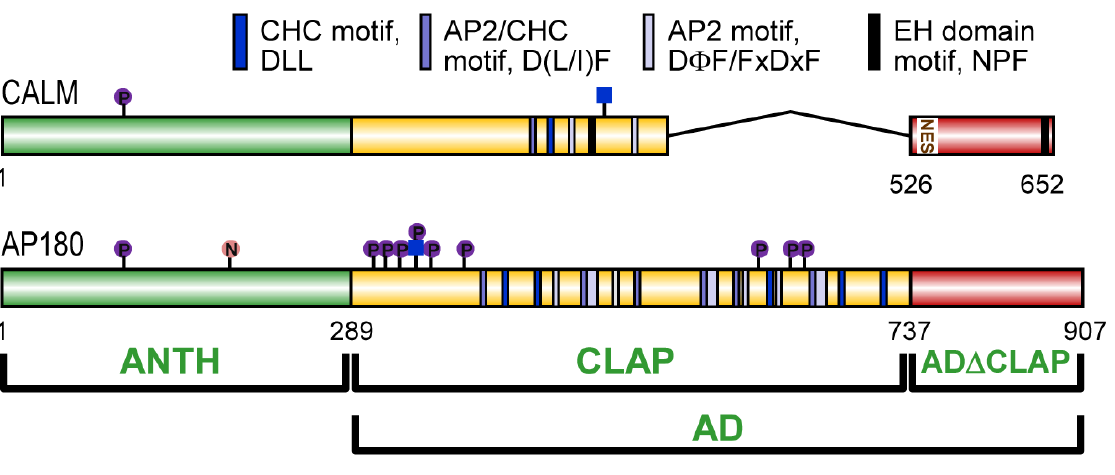
Figure 2. Domain structure of human CALM and AP180. AP180 consists of an AP180 N-terminal homology (ANTH) domain and an assembly domain (AD). The AD has two subdomains: a clathrin and adapter (CLAP) domain and the remainder is an unnamed domain (AD Δ CLAP). CALM has a nuclear export signal (NES). AP180 is nitrated (“N” in orange circle), phosphorylated (“P” in purple circle) and O-GlcNAc-6-phosphate modified (blue square with “P” in purple circle above). CALM is phosphorylated and O-GlcNAc modified (blue square only). Clathrin heavy chain (CHC), AP2 and eps15 homology (EH) domain binding motifs are